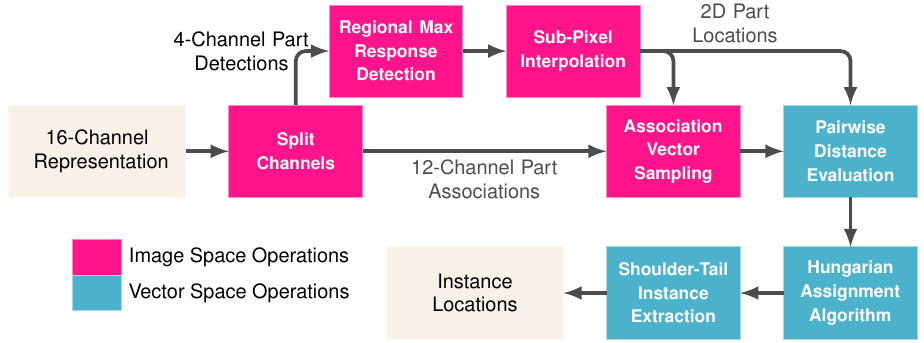
Figure 4. Flow diagram of the proposed method for converting the 16-channel image space representation to a set of 2D coordinates of each visible